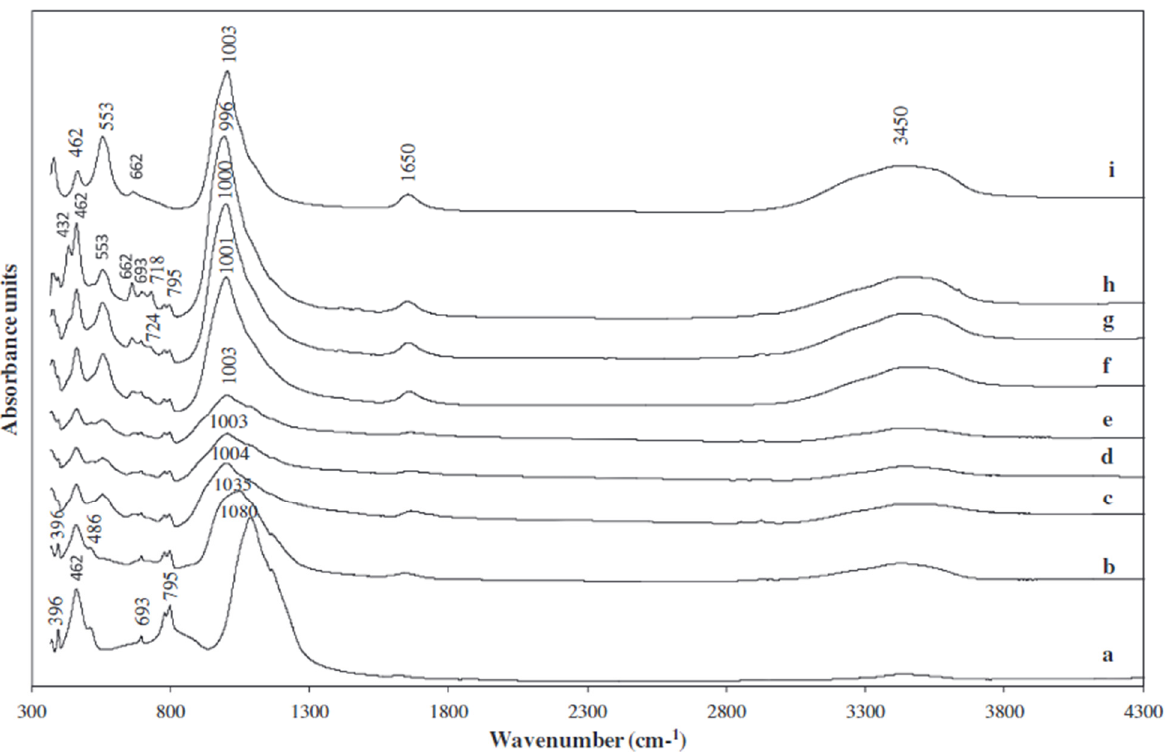
Figure 6. FTIR spectra of zeolite A and associated phases obtained by hydrothermal synthesis: (a) unreacted metakaolin, (b) 1.0M NaOH, (c) 1.5M NaOH, (d) 2.0M NaOH, (e) 2.5M NaOH, (f) 3.0M NaOH, (g) 3.5M NaOH, (h) 4.0M NaOH, and (i) commercial zeolite A (Fluka No. 69836) (From JAAUBA Ref. [77]